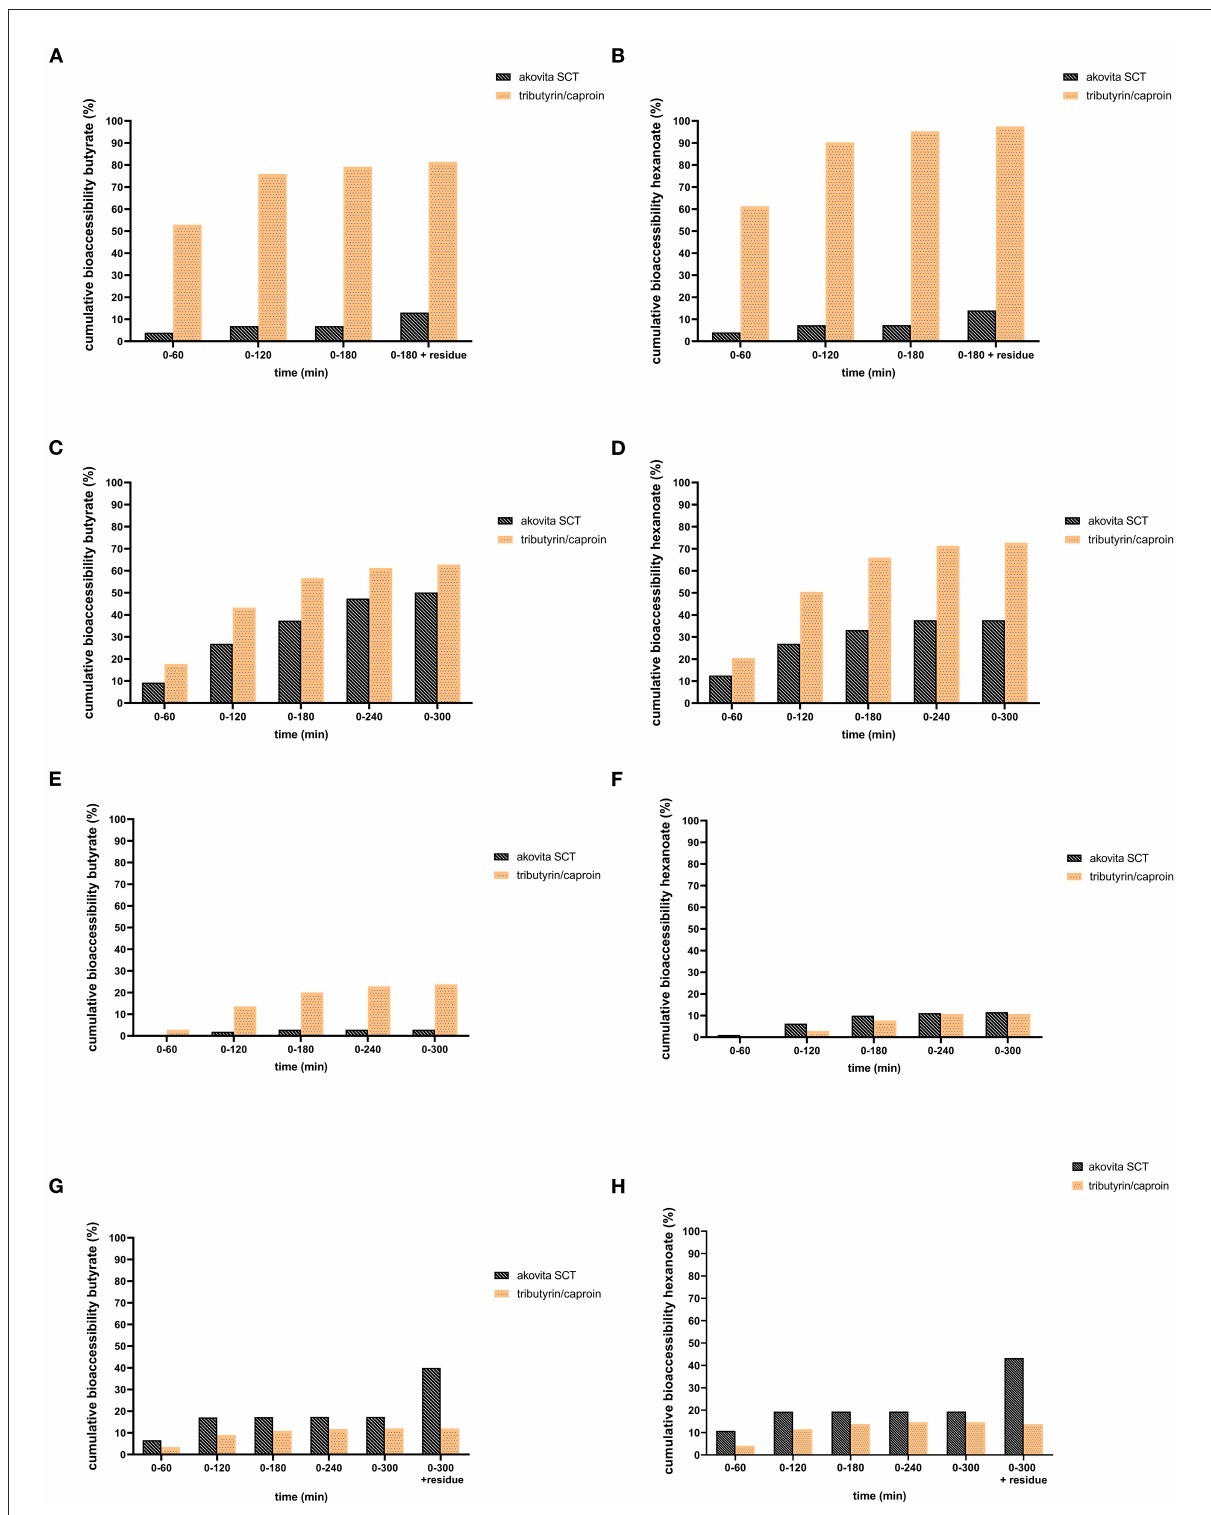
FIGURE2 Comparison of cumulative bioaccessibility of butyrate (A, C, E, G) and hexanoate (B, D, F, H) from Akovita SCT or tributyrin/caproin in TIM-1 (as percentage of intake after correction for recovery). (A, B) Gastric compartment. (C, D) Jejunum compartment. (E, F) Ileal compartment. (G,